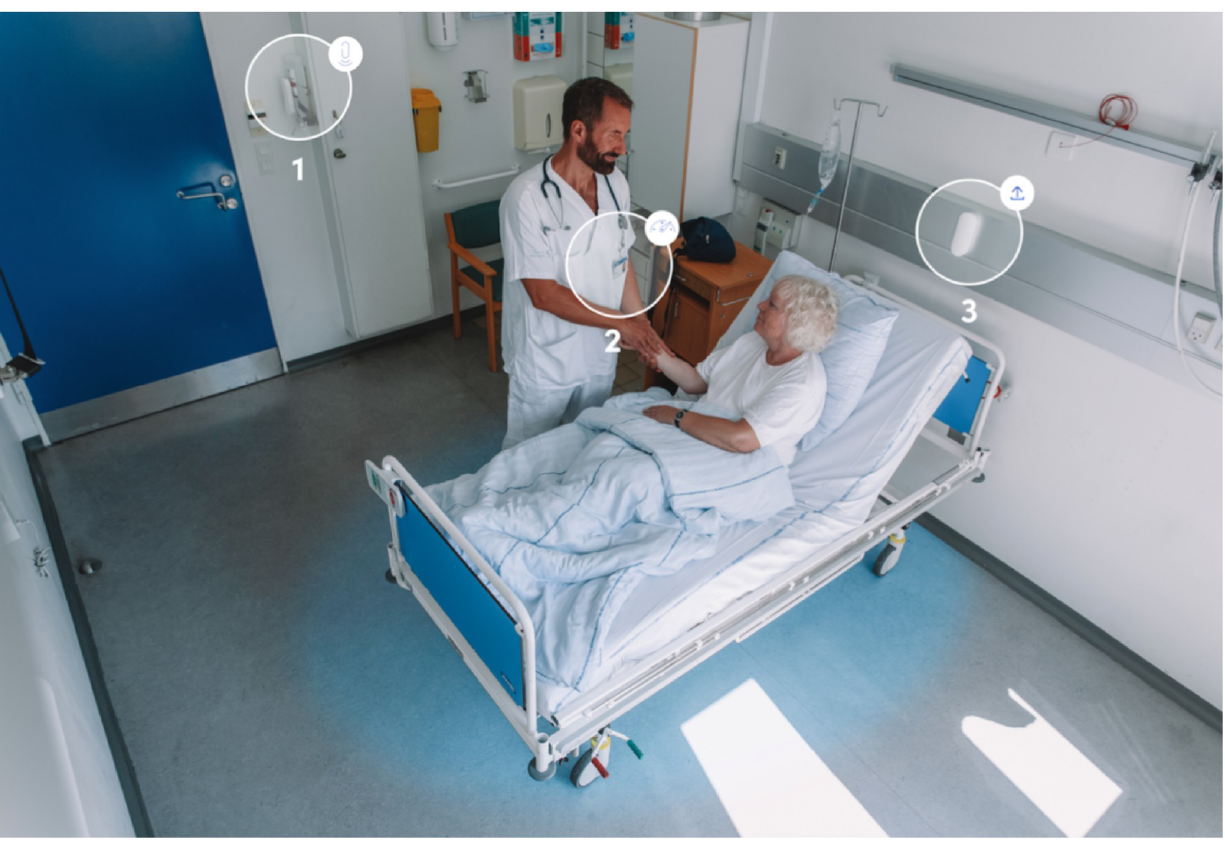
Fig 1. The Sani nudge hygiene system in a hospital patient room. 1 . A Sensor on a dispenser registering the number of alcohol-based hand rubbing events; 2 . An anonymous sensor on the name badge of each healthcare worker. The sensor is coded according to staff profession. 3 . The patient zone (illustrated with blue) created by the sensor near the head of the patient bed. Data captured by the sensors are sent to a secure cloud-based server and stored at the device level. The two persons in the figure are volunteers and not part of the study.